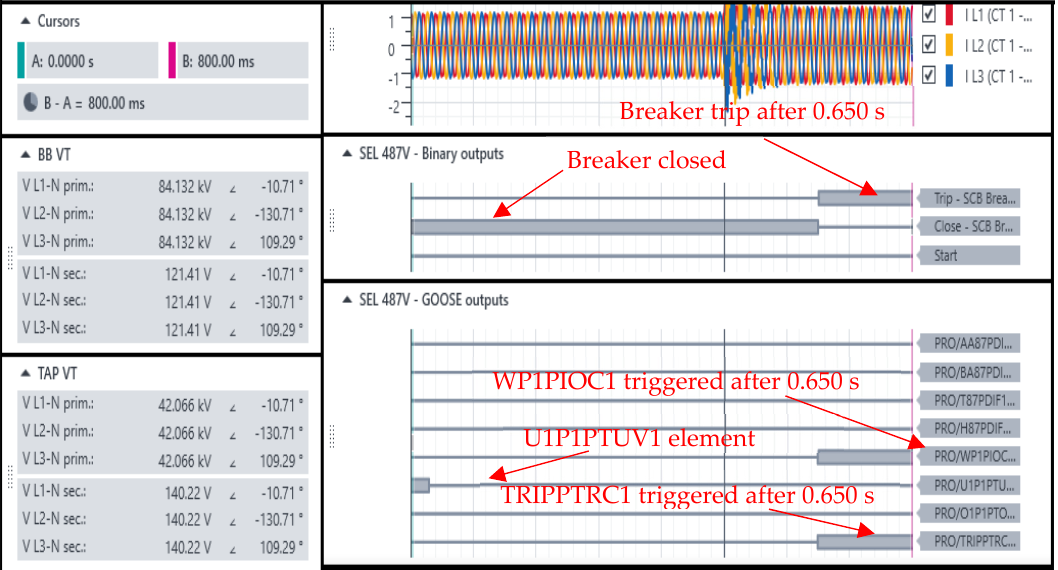
Figure 8. RelaySimTest simulation results for a simultaneous failure of six element failures above and below the tap.